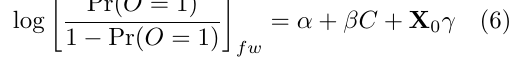
attrition, any analysis will produce biased